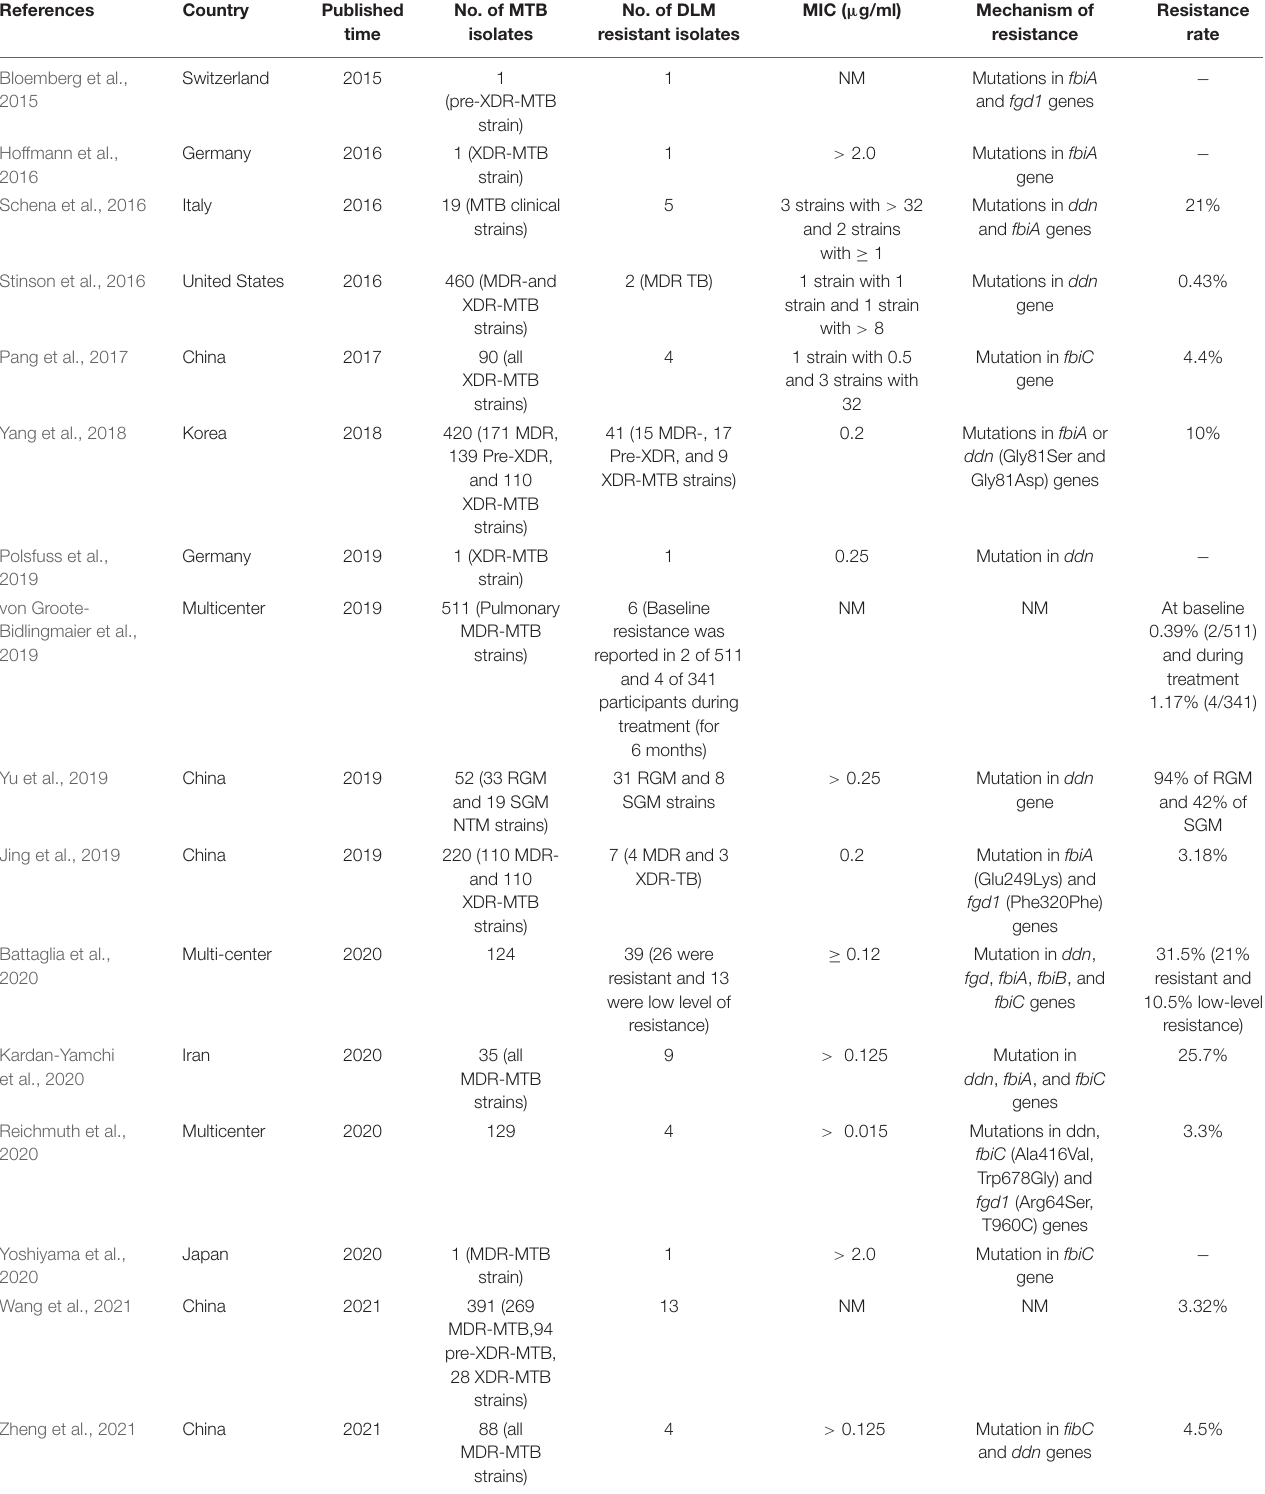
TABLE 1 | Epidemiology of delamanid